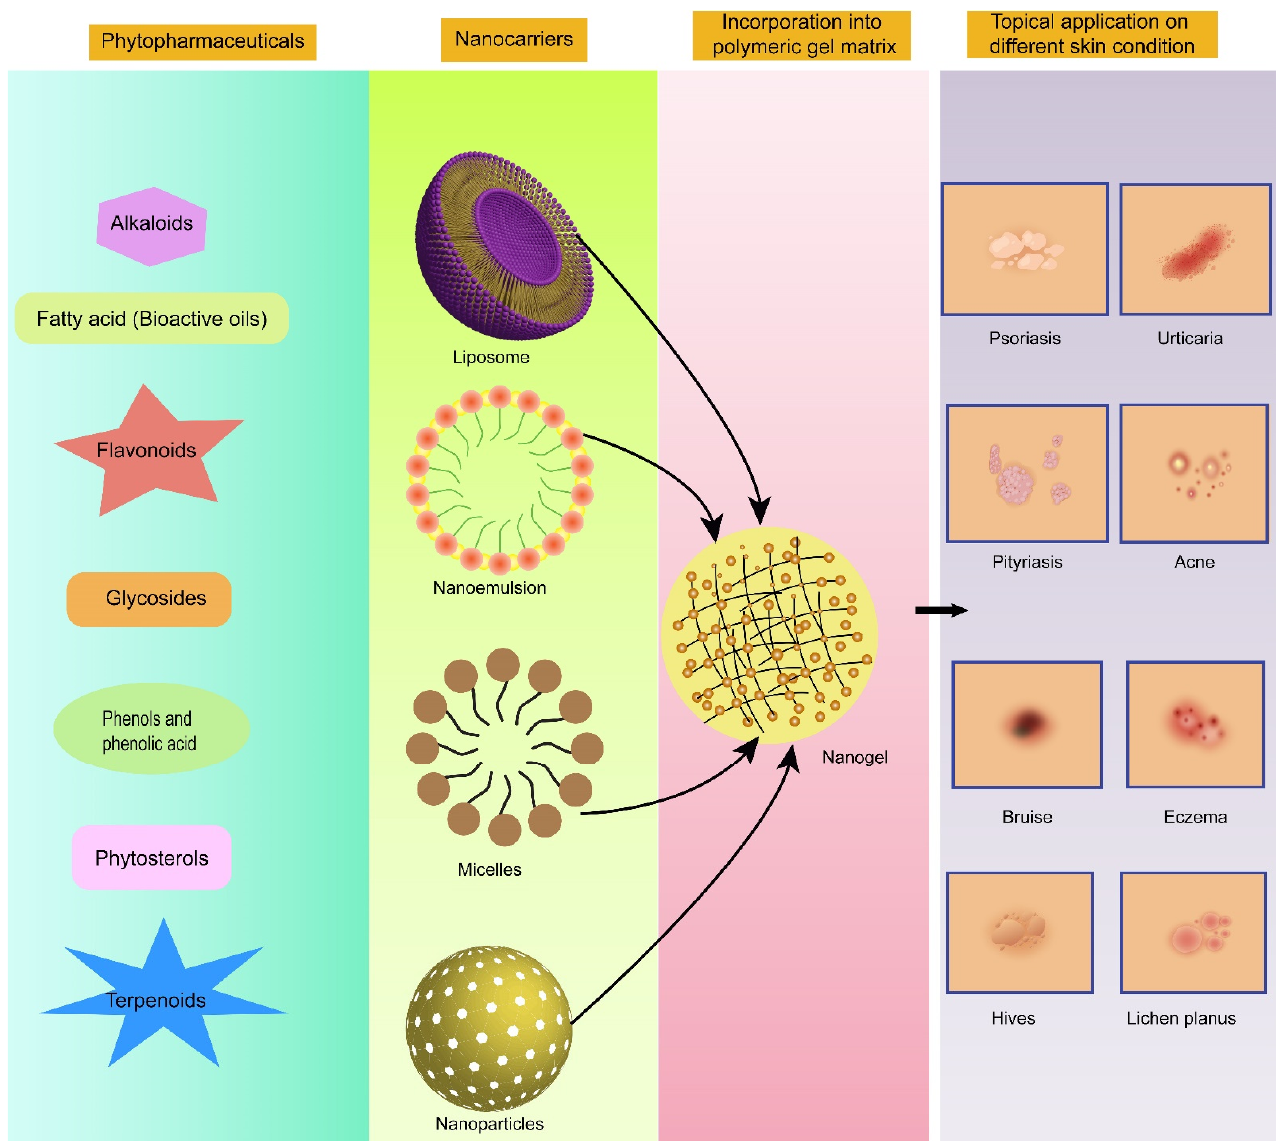
Figure 2. Promising category of phytopharmaceuticals exploiting nanogels as a delivery vehicle for topical application in different skin